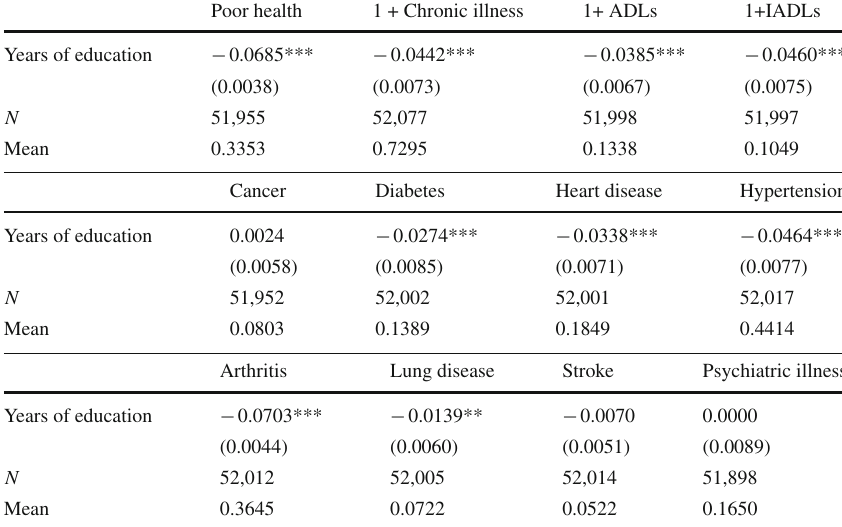
Table 7 IV-Probit models of years of education on health outcomes (coefficients reported as marginal